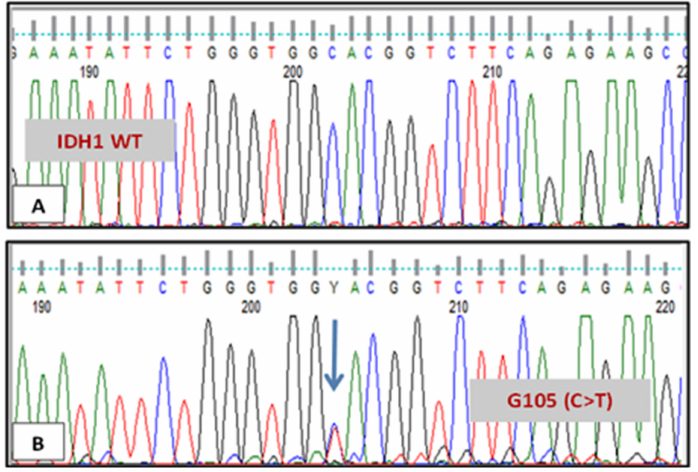
Figure 2. Sequencing result of IDH1 in two different patients. ( A ) Patient with normal IDH1 sequence at codon G105. ( B ) Patient with IDH1 mutation at codon G105